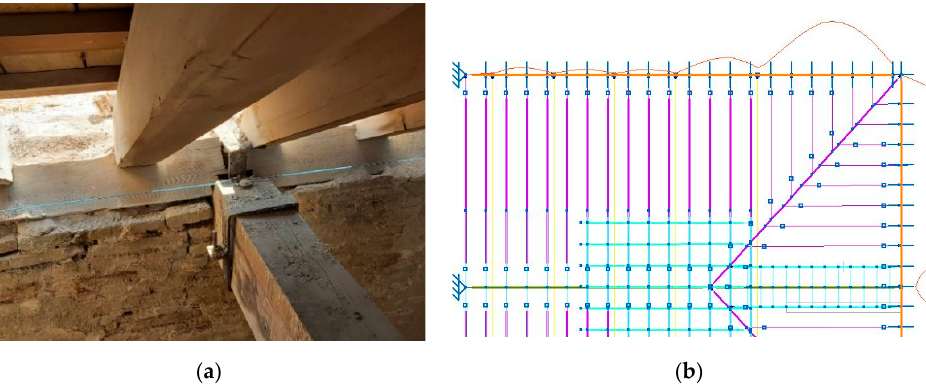
Figure 22. ( a ) Wall plate break due to rot. Piece found at the EP4 sector before the repair works; ( b ) displacements of the studied wall plate (orange line) in the freedom movement simulation (without the wall link).